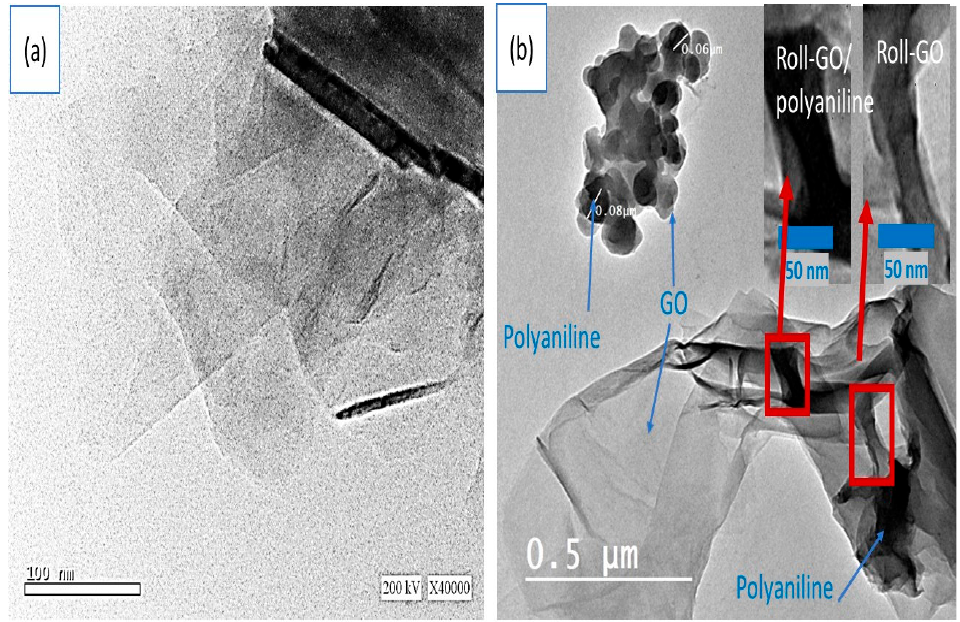
Figure 3. TEM of ( a ) roll-GO and ( b ) the nanocomposite